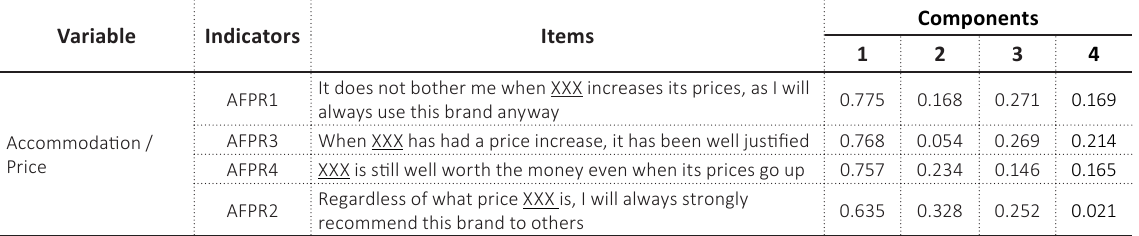
Table 3. Exploratory factor analysis